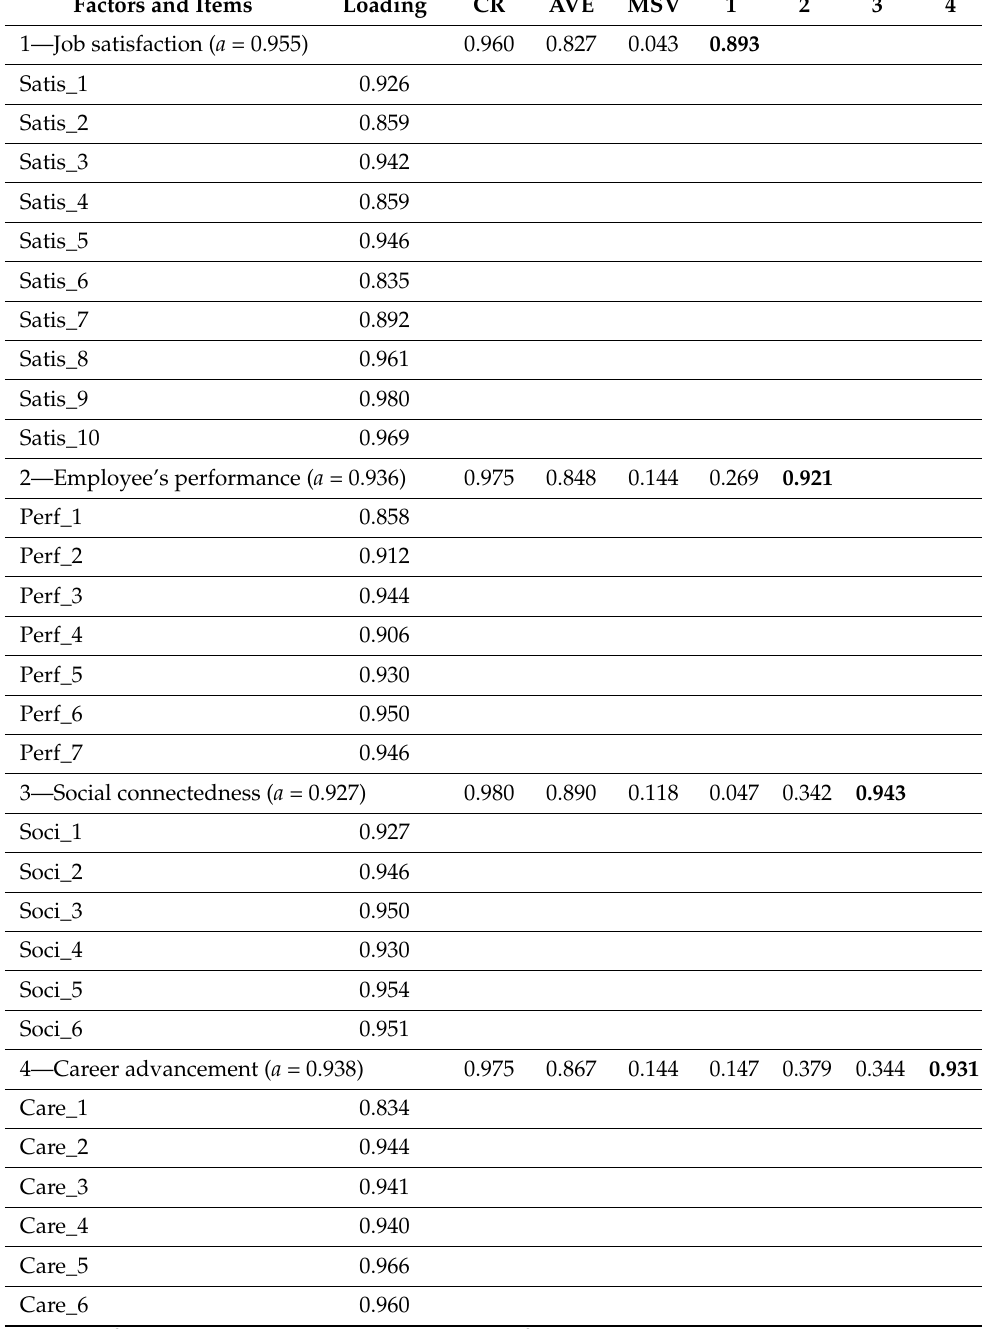
Table 3. First-order factor analysis convergent and discriminant validity. Factors and